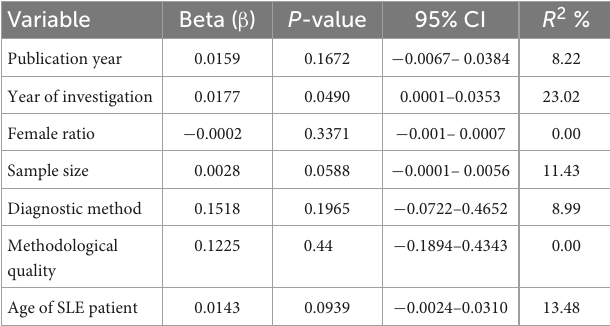
TABLE 3 Univariate meta-regression